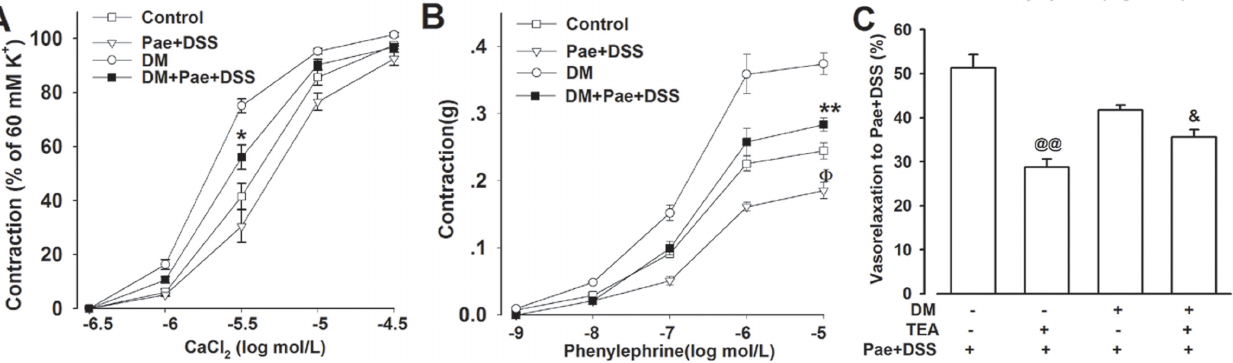
Figure 5. Effects of Pae + DSS on calcium channels and K + channel. ( A ) Rings without endothelium from control and diabetic rats were pre-incubated with or without Pae + DSS in the Ca 2+ free solution (containing 10 M to 4 M at 0.5 g/L for 10 min; the curves of CaCl 2 EGTA and 60 mM KCl) were inhibited by Pae + DSS ( n = 6); ( B ) Pre-incubation with Pae + DSS at 0.5 g/L for 10 min signi fi cantly inhibited the vasocontraction of PE in Ca 2+ free solution containing 10 M to 4 M EGTA of rings without endothelium from control and diabetic rats ( n = 6); ( C ) Non-selective K + channel blocker tetraethylammonium (TEA, 10 mmol/L) was pre-incubated with rings from control and diabetic rats for 10 min prior to stimulation with 1 µmol/L of PE. Pae + DSS (0.5 g/L) was added after the PE